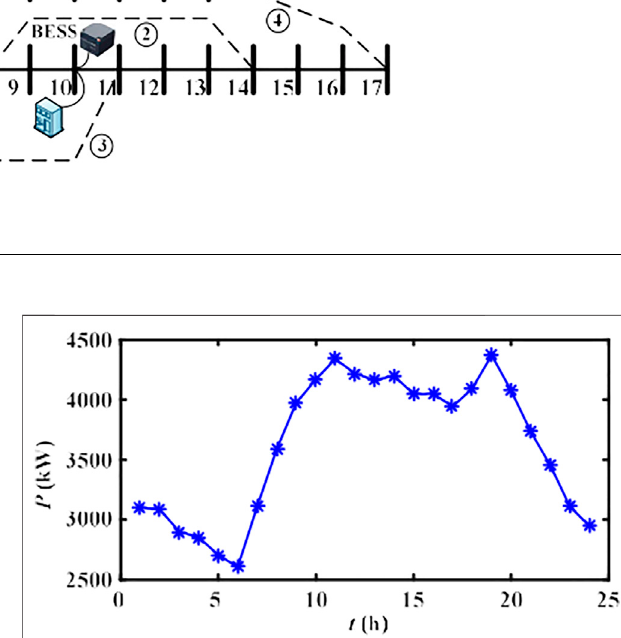
FIGURE 10 | Daily original power load.